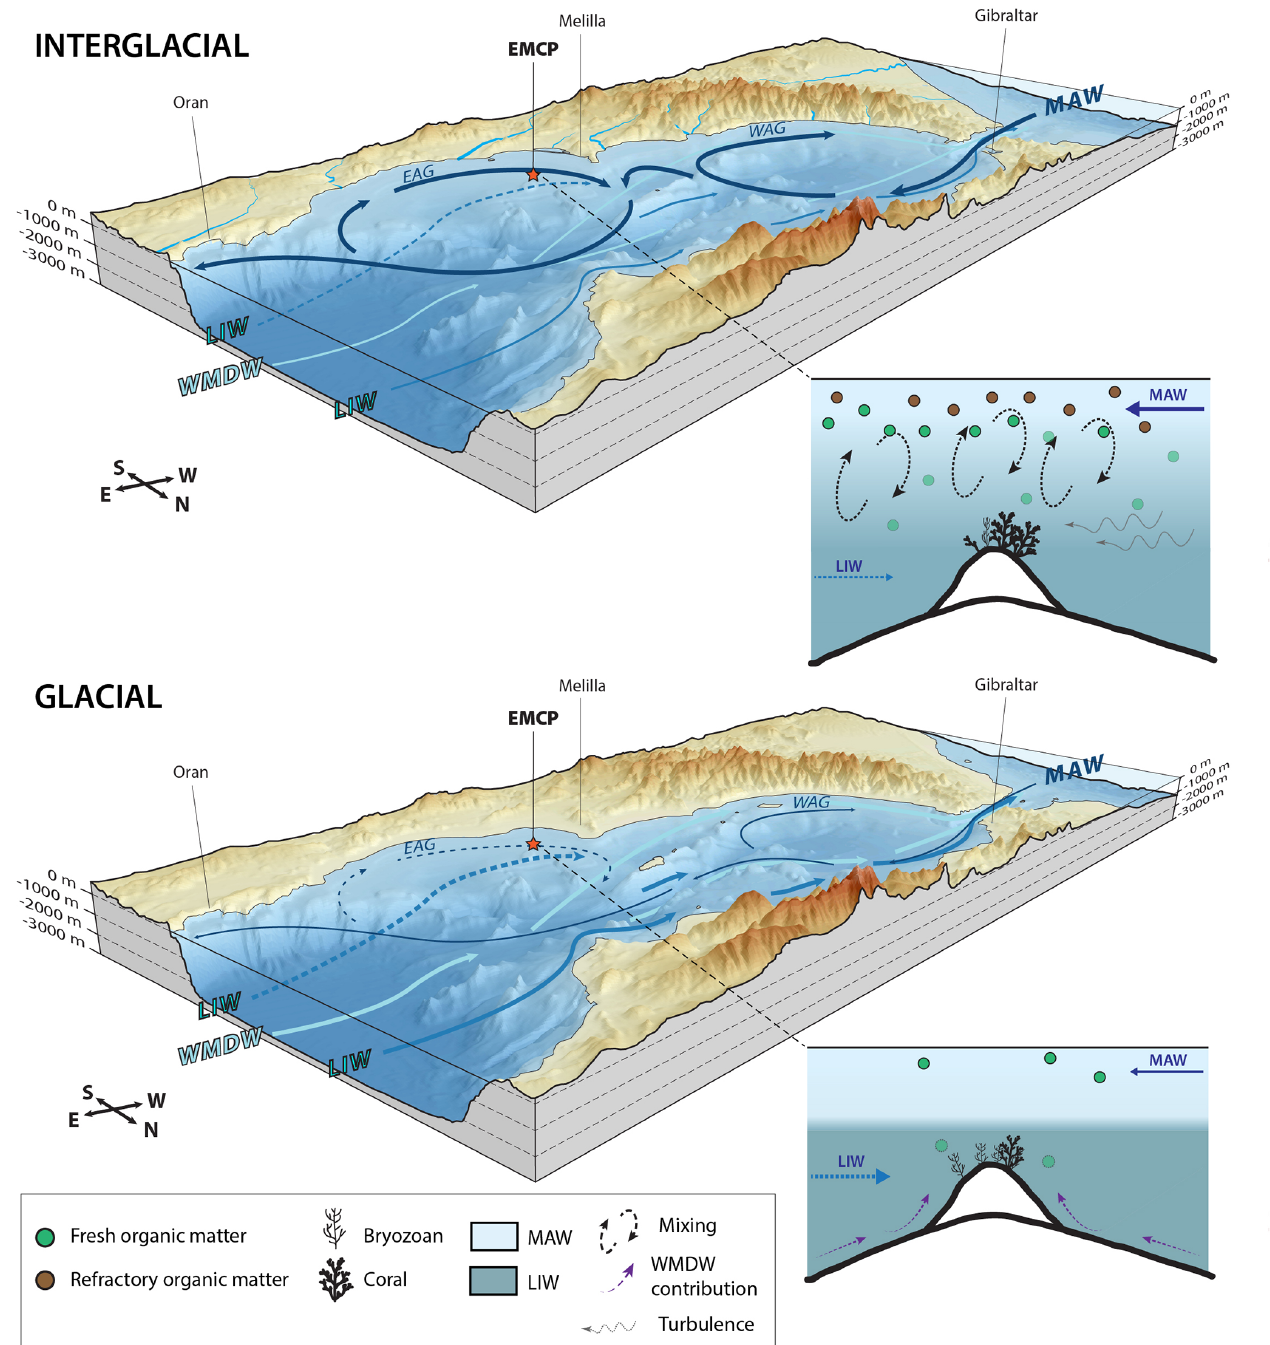
Figure 10. Three-dimensional diagrams and schematic models illustrating the differences between interglacial and glacial periods as well as the response of the benthic community at Brittlestar Ridge I. Water masses discussed in the text are illustrated (MAW: Modified Atlantic Water, LIW: Levantine Intermediate Water, WMDW: Western Mediterranean Deep Water) as are the Western Alboran Gyre (WAG) and Eastern Alboran Gyre (EAG). The flow strength of each water mass is depicted by the thickness of the arrows. The red star indicates the location of the East Melilla Coral Province. The position of the EAG and WAG is based on observations made by Lanoix (1974), La Violette (1983), and Viúdez and Tintoré (1995). Sea level of interglacial periods corresponds to the current sea level, whilst a 100m lower sea level stand, following observations made by Rabineau et al. (2006), illustrates glacial periods. The LIW and WMDW flows have been simplified and thus do not represent their exact dynamics. The schematic models are not to scale, although relative depth limits between MAW and LIW have been respected. GEBCO_2019 gridded bathymetric data were used to construct the